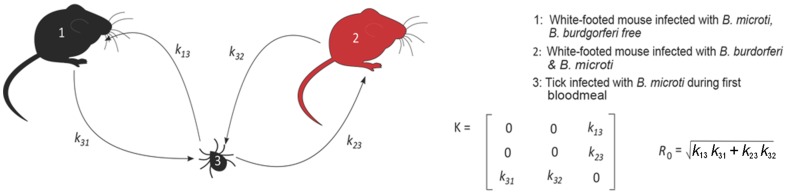
The transmission graph for Babesia microti for singly infected and coinfected mice.Three ‘host types’ are defined: (1) Peromyscus leucopus mouse, Borrelia burgdorferi free, infected with B. microti, (2) P. leucopus mouse infected with B. burgdorferi and B. microti and (3) tick infected with B. microti during first blood meal. The transmission graph is used in the construction of the next-generation matrix (K) for R
0 where kij indicates the expected number of host type i infected by host type j.